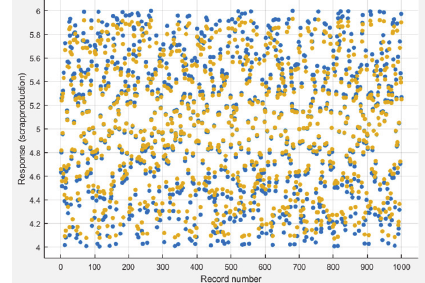
Fig. 14. Predicted response vs true response for shortage prediction